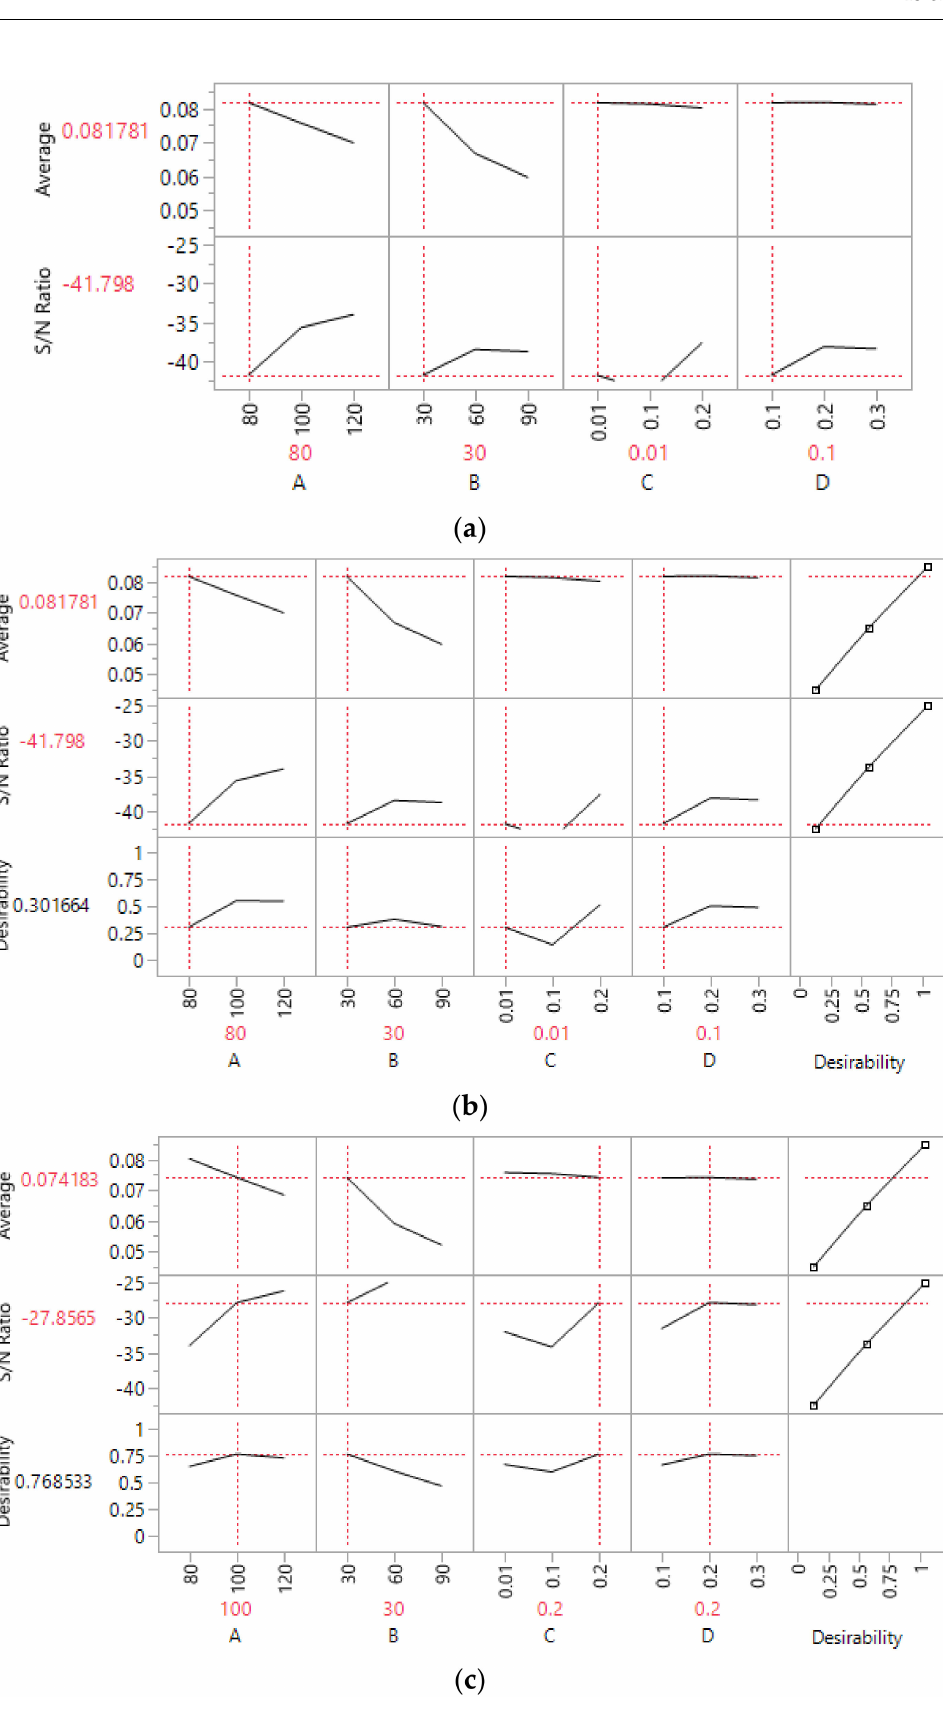
Figure 7. S/N analysis for the determination of the optimal parameters of the network: ( a ) normal profile; ( b ) desirability profile; ( c ) maximized desirability